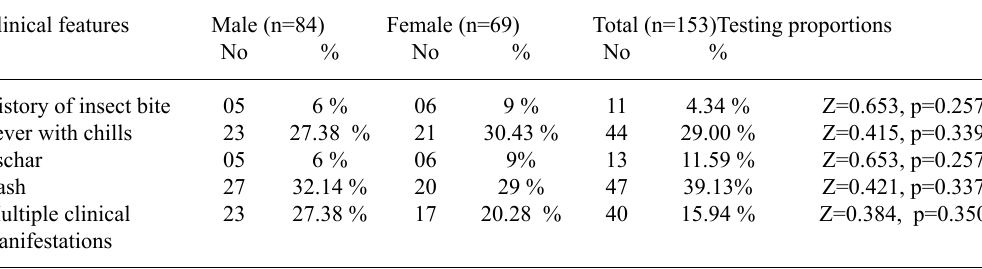
Table 3. Pattern of Orientia tsutsugamushi isolated from various clinical features among male and female (n=153) Clinical